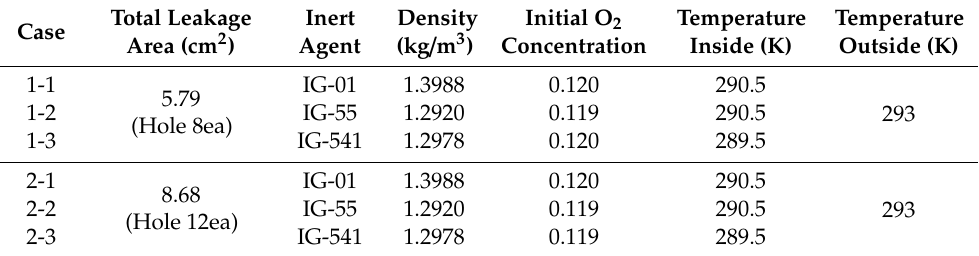
Figure 8. Change in the interface slope 𝛼 over time for each agent (average value of 5 data).